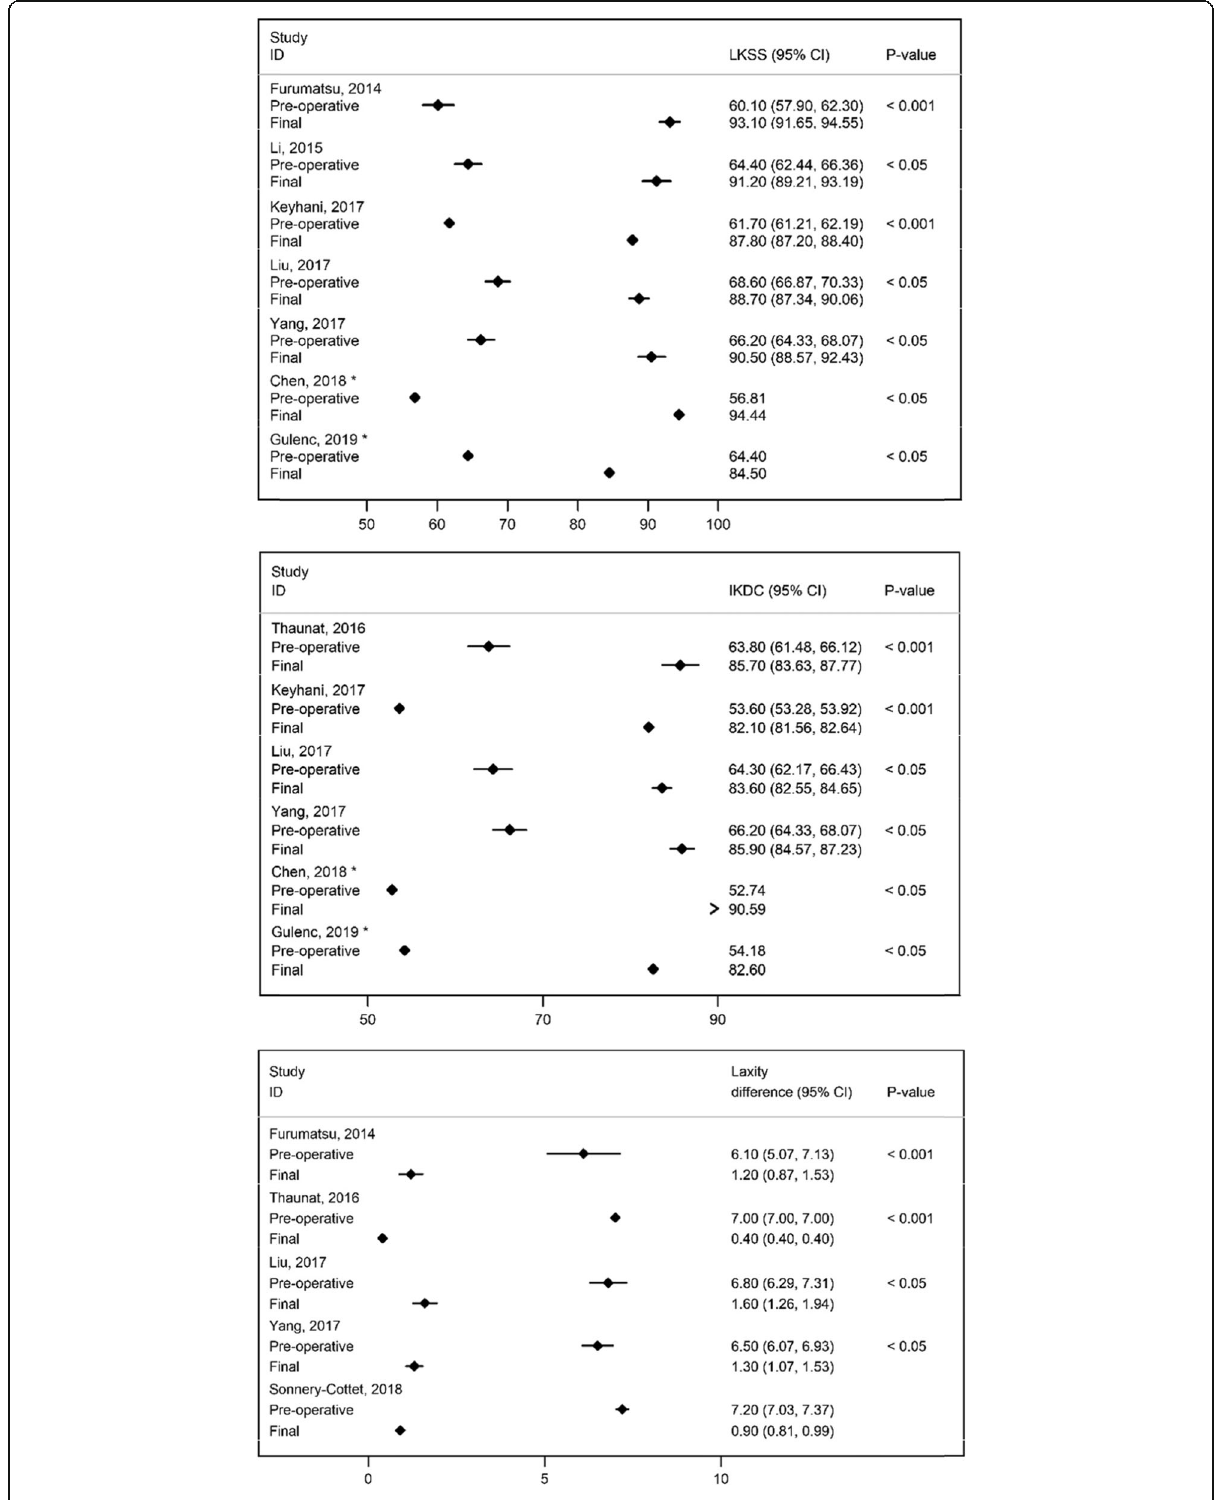
Fig. 4 Forest plots grouping the mean Pre-operative and Final (at final follow-up) Lysholm Knee Scores, International Knee Documentation Committee scores and laxity differences between the affected and the unaffected knee. Dots in squares represent the estimated measures while the horizontal lines represent the 95% CI. *only point estimates are presented because no confidence intervals or information to compute them were available from these